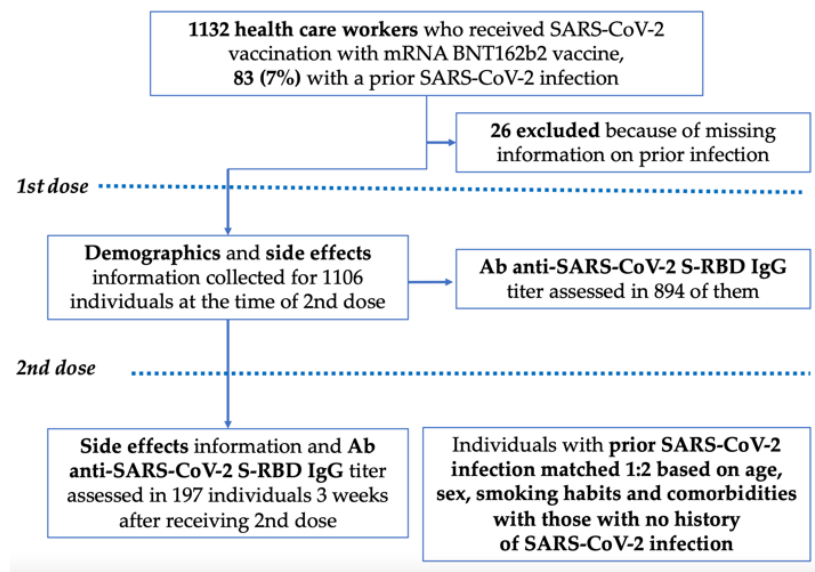
Figure 1. Study design. Flow chart describing the population of health care workers (HCW) analyzed in the study. For the case–control analysis, 249 subjects were enrolled (83 cases and 166 con- trols).